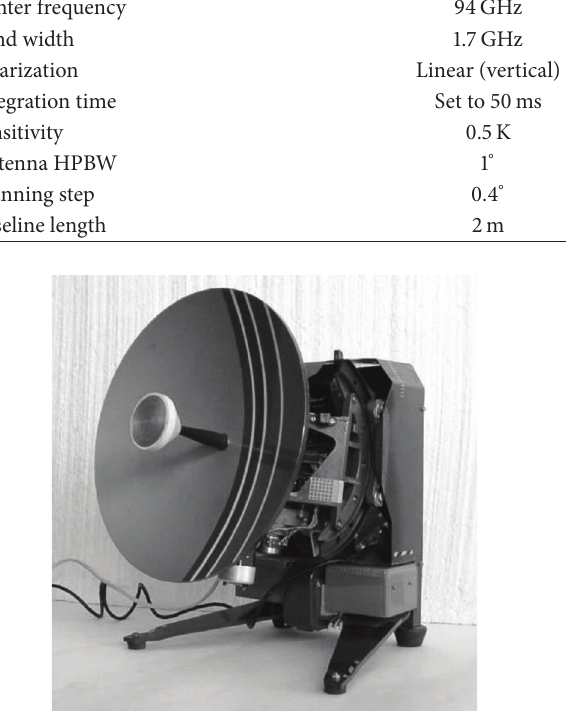
Figure 1: External appearance of the 3mm imaging system for dem- onstration purposes.